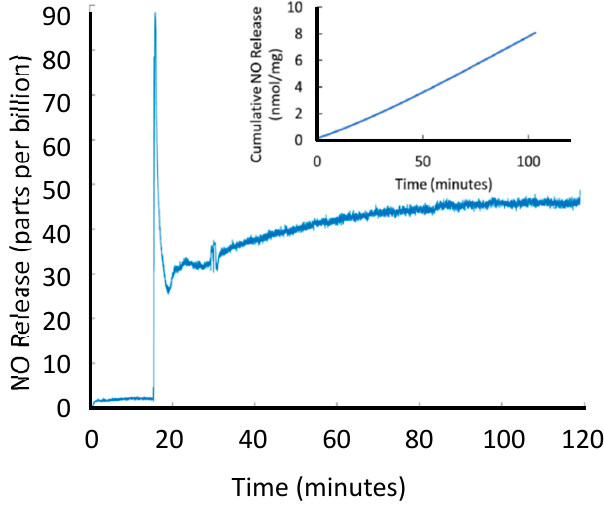
Figure 3. Passive NO release of 2 mL of SNAP-HPAMAM solution (1 mg/mL) in phosphate buffered saline (PBS) at 37 °C.